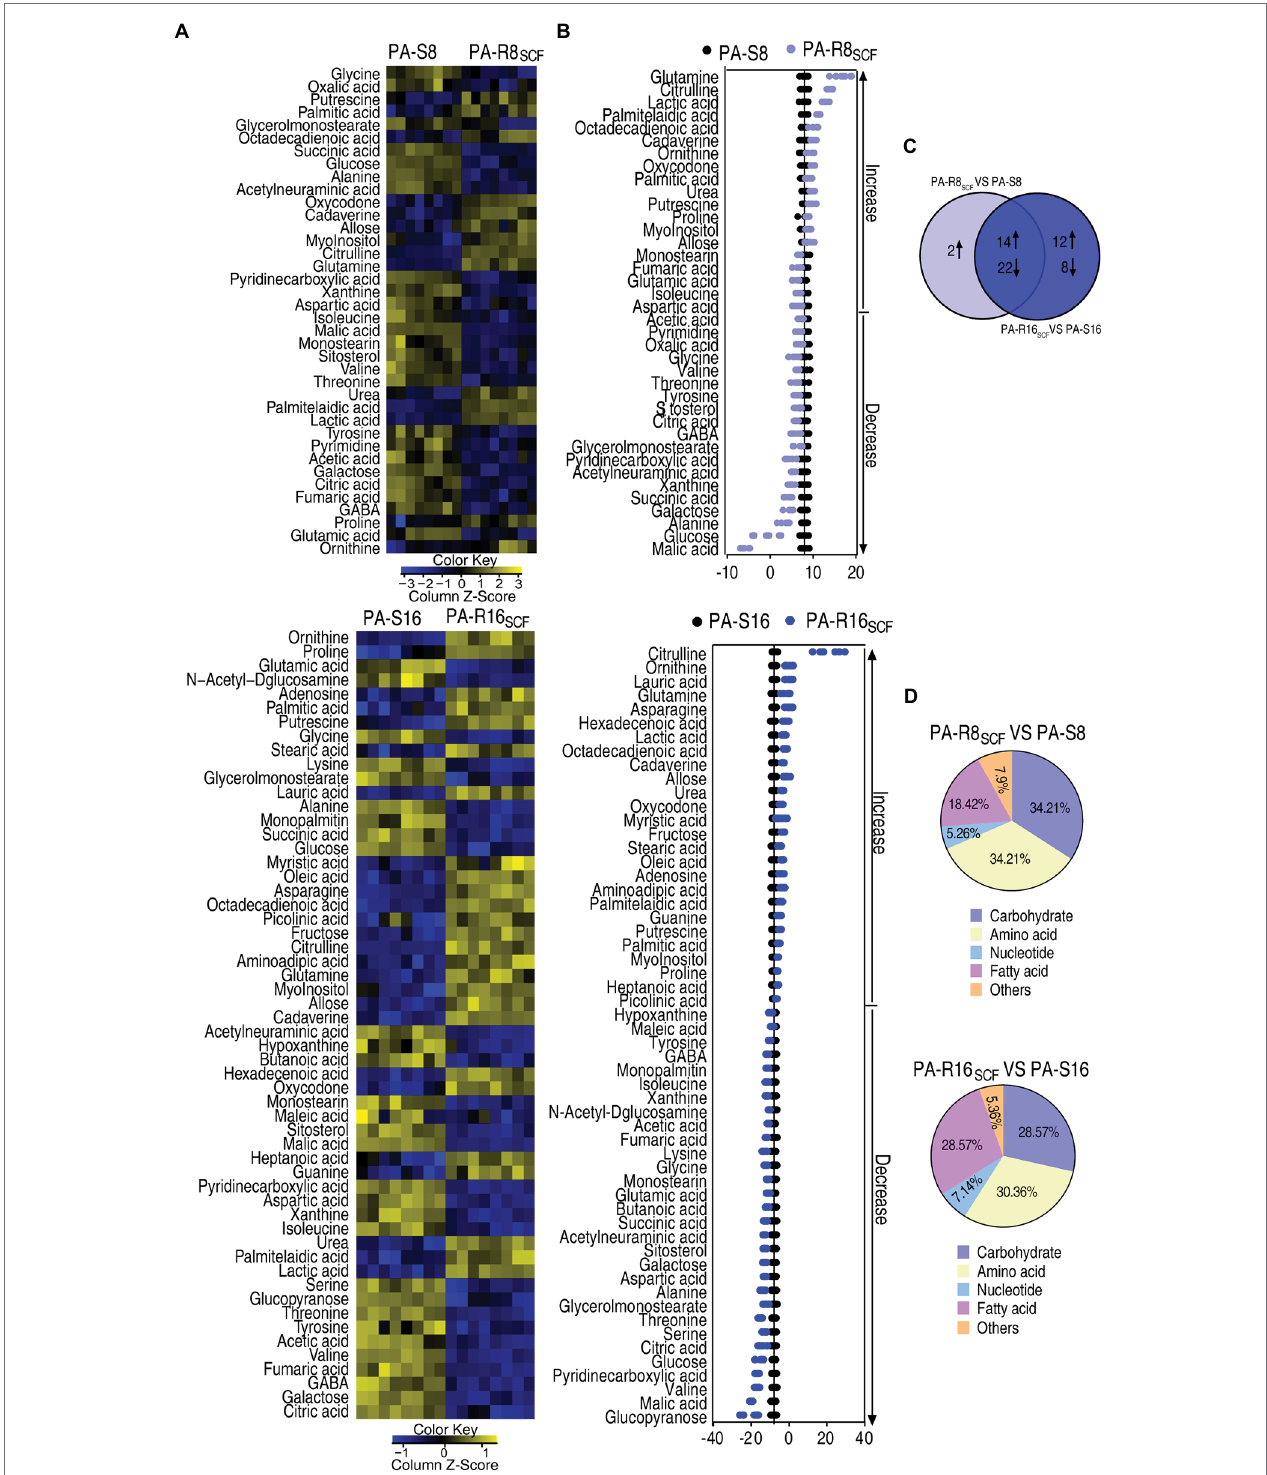
FIGURE 3 | Differential metabolome of SCF-resistant Pseudomonas aeruginosa . (A) Heat maps showing differential metabolites in PA-R8 SCF and PA-R16 SCF compared with those in PA-S8 and PA-S16, respectively. Yellow color and blue color indicate increase and decrease of metabolites relative to the median metabolite level, respectively (see color scale). (B) Z-score plot of differential metabolites in PA-R8 SCF and PA-R16 SCF based on controls PA-S8 and PA-S16, respectively. The data were separately scaled to the mean and SD of the controls. Each point represents one metabolite in one technical repeat and colored by sample types. (C) Venn diagram for comparison of differential metabolites between PA-R8 SCF and PA-R16 SCF . (D) Categories of the differential metabolites. Differential abundances of metabolites are searched against in KEGG for their categories, and the pie chart is generated in Excel 2010 (Microsoft, United